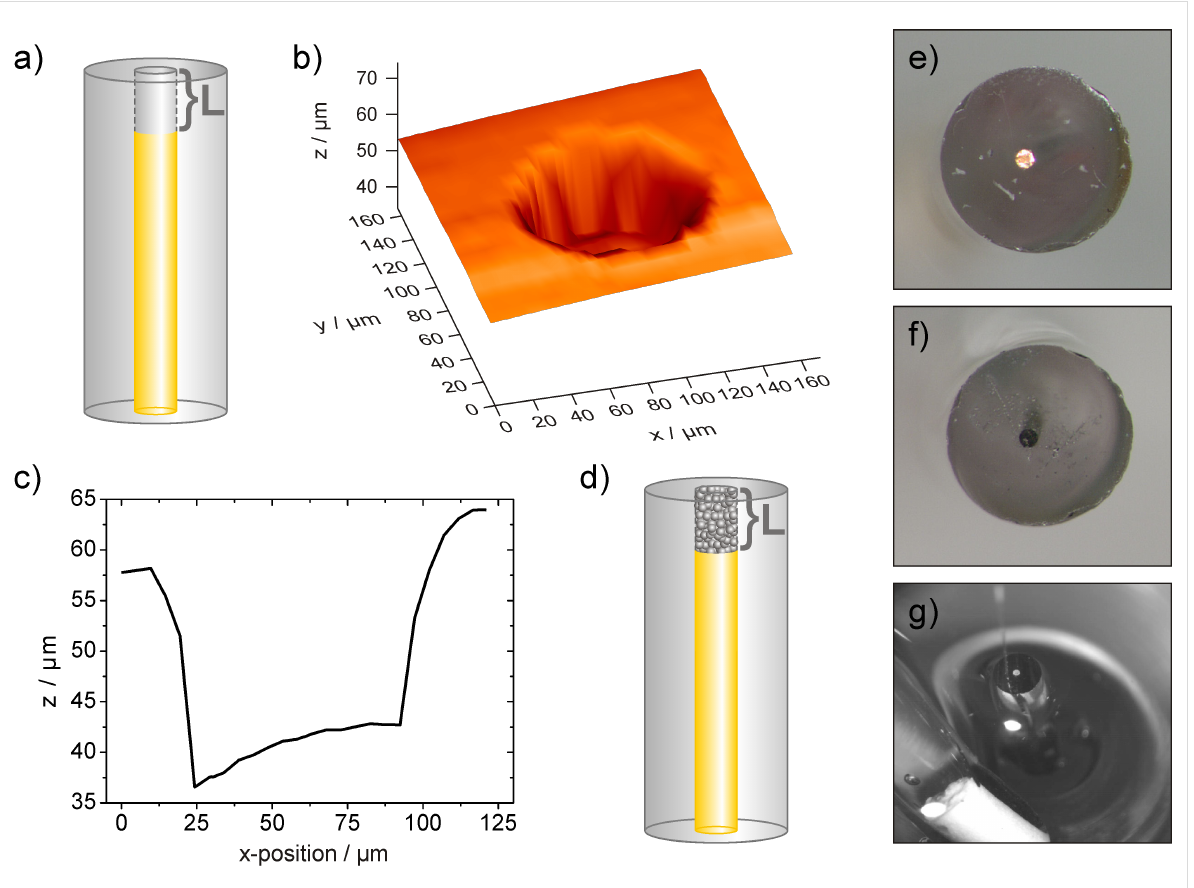
Figure 2: a) Scheme of a microcavity used as platform for catalyst immobilisation in cd-mode SECM investigations. b) Topography of the cavity obtained by means of shearforce-based cd-scanning and a corresponding linescan shown in c). d) Scheme of the microcavity electrode filled with catalyst powder. Optical micrographs of the cavity electrode before e) and after f) filling with catalyst powder. Residues of the black Pt/C catalyst are visible at the glass insulation and are removed before the filled cavity is inserted in the SECM measuring cell. g) Micrograph of the setup for 4D